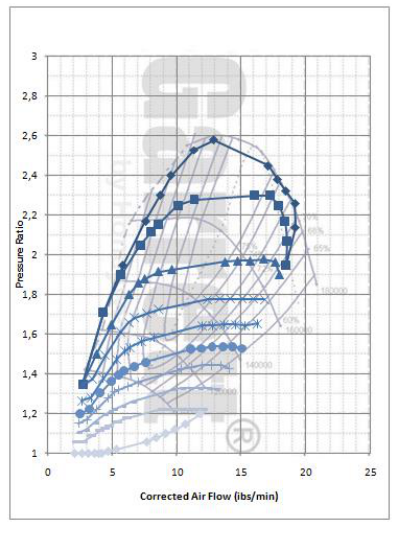
Fig. 6. The course of the boost pressure – serial 2